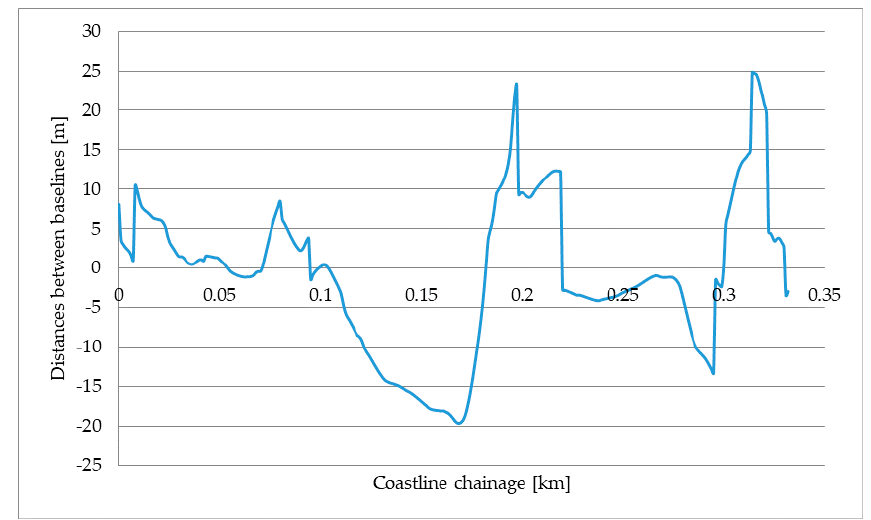
Figure 9. Distances between territorial sea baselines determined by the geodetic method in 2016 and 2018.